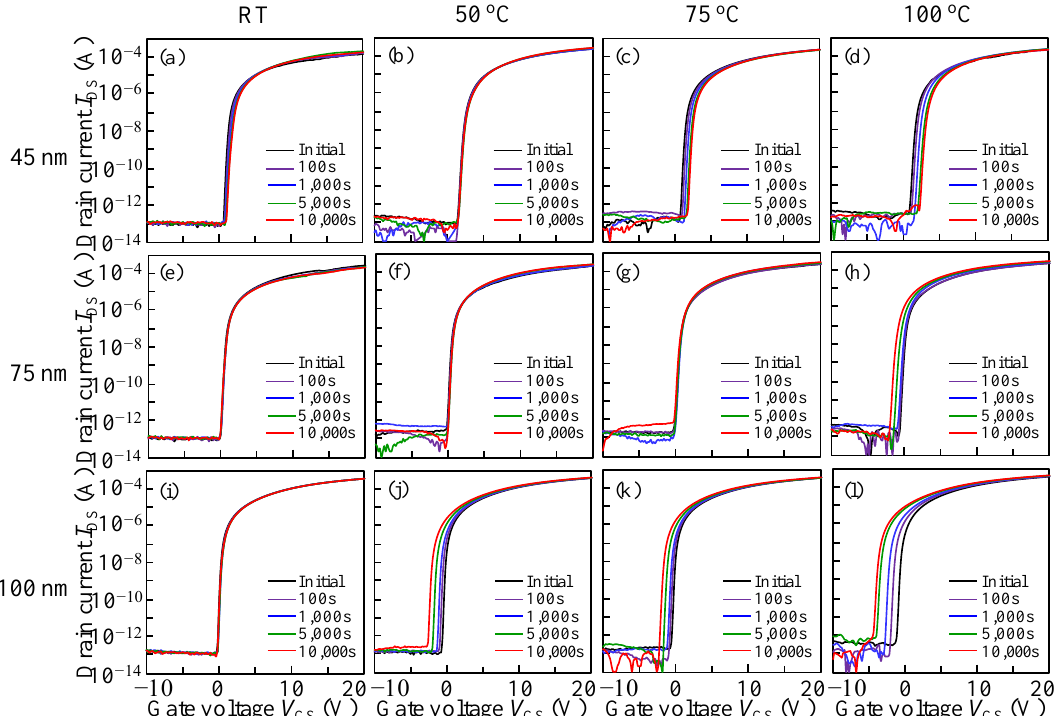
Figure 4. Evolution of transfer characteristics as a function of DCS ( V GS = V DS = 10 V) duration for 10 4 s for the devices with a T ITZO of 45 nm measured at test temperatures of ( a ) 25, ( b ) 50, ( c ) 75, and ( d ) 100 ◦ C; with a T ITZO of 75 nm measured at test temperatures of ( e ) 25, ( f ) 50, ( g ) 75, and ( h ) 100 ◦ C; and with a T ITZO of 100 nm measured at test temperatures of (i) 25, ( j ) 50, ( k ) 75, and ( l ) 100 ◦ C.